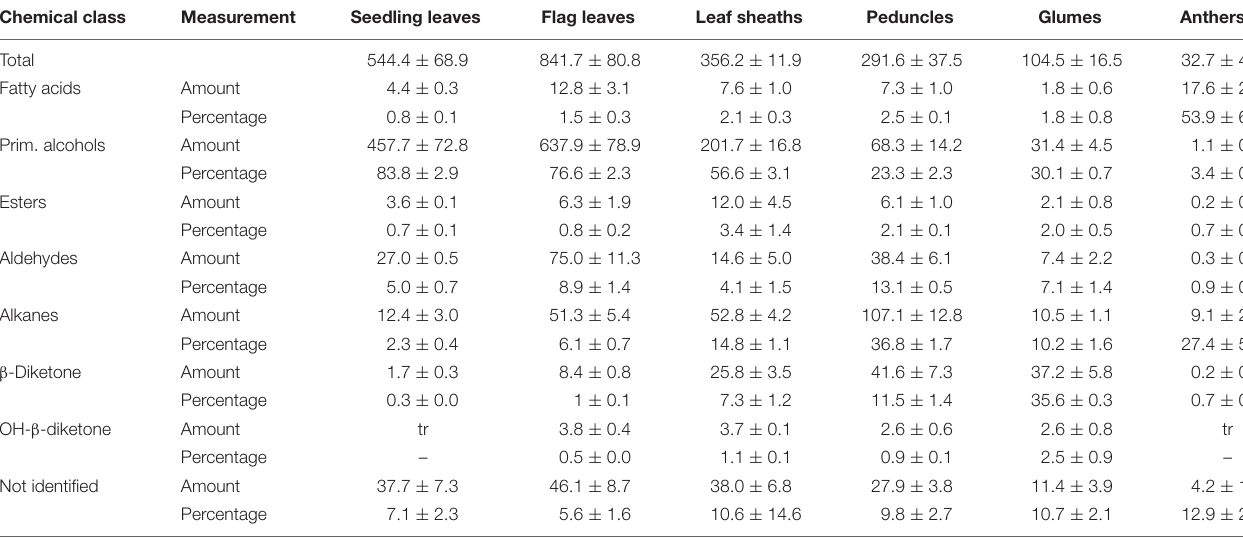
TABLE 1 | Wax composition of seedling leaves, flag leaves, leaf sheaths, peduncles, glumes and anthers of in Aegilops tauschii . Chemical class